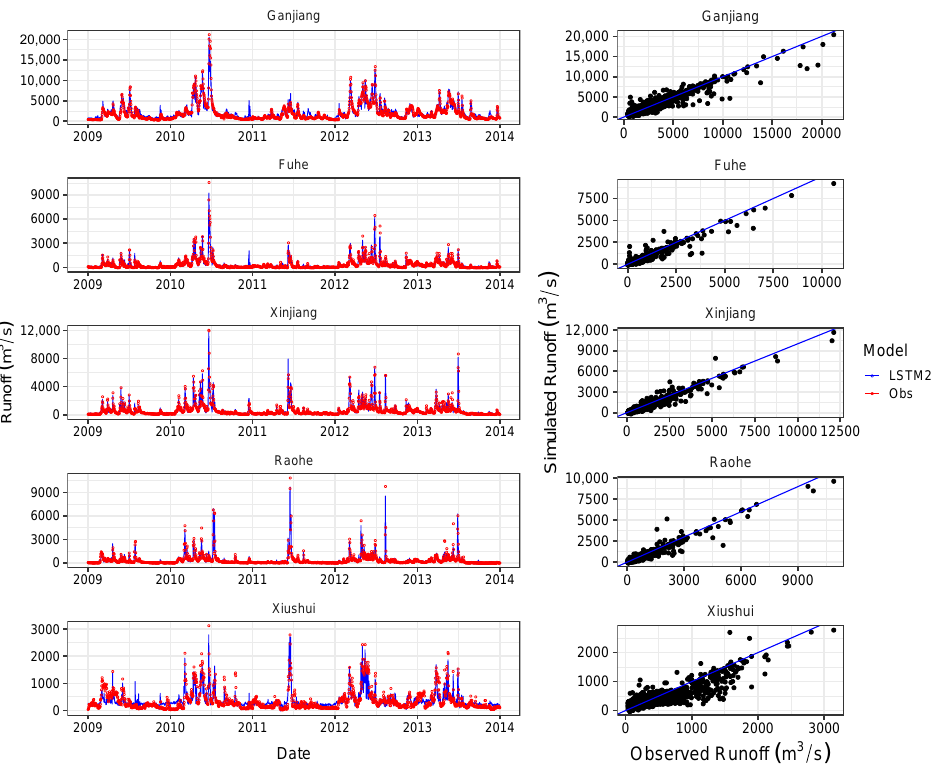
Figure 8. Performance of LSTM 2 during the validation period for all five